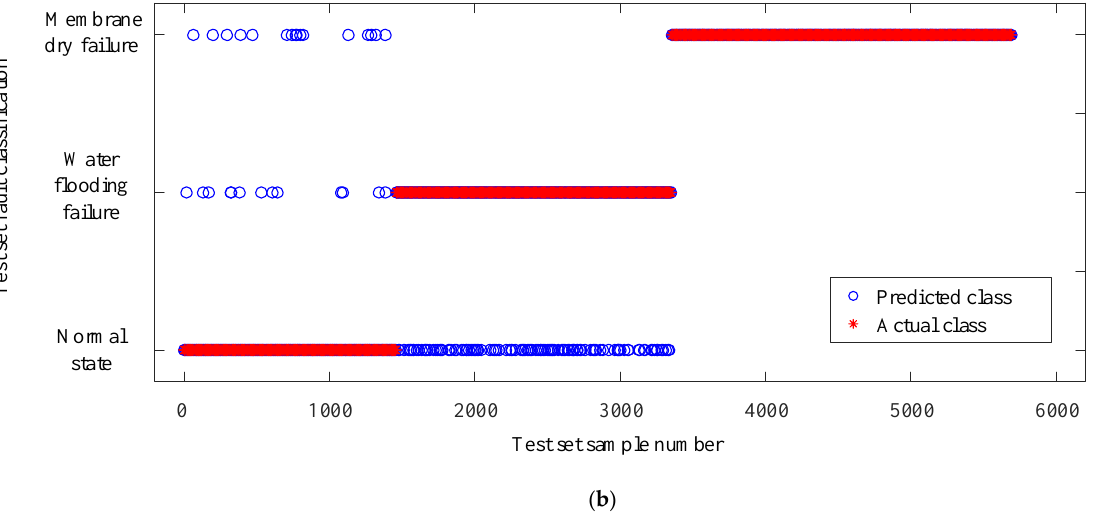
Figure 8. Diagnostic results of KPCA-LVQNN. ( a ) Training diagnostic results; ( b ) test diagnostic results.